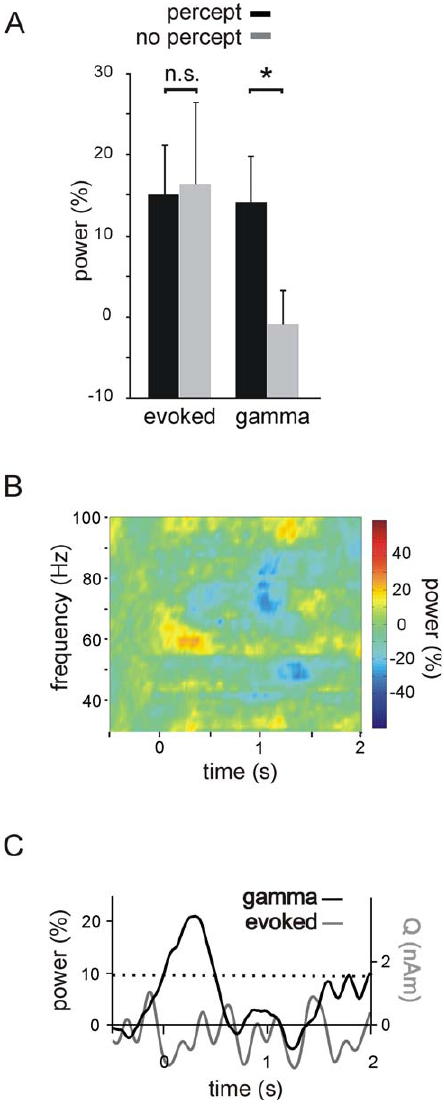
Figure 4. Amplitudes of Induced Gamma Oscillations and Evoked Responses to Differently Perceived Stimuli of Equal Stimulus Intensity (A) Trials rated with zero ( ‘‘ no percept, ’’ black bars) were compared to trials with higher ratings ( ‘‘ percept, ’’ gray bars) but the same stimulus intensity. Amplitudes of responses were calculated as relative power changes as compared to baseline. Mean rating of ‘‘ percept ’’ trials was seven, the mean number of trials per subject was 16. ‘‘ Percept ’’ and ‘‘ no percept ’’ trials were equally distributed across the recording session (ratio of the number of ‘‘ percept ’’ and ‘‘ no percept ’’ trials compared across quarters of the recording session; p ¼ 0.14; Friedman’s analysis of variance). Mean amplitudes of gamma oscillations in S1 at 100–300 ms were significantly stronger for ‘‘ percept ’’ trials as compared to ‘‘ no percept ’’ trials. Amplitudes of evoked responses from S1 did not differ between conditions. The asterisk (*) indicates p , 0.05. (B) TFR of the difference between ‘‘ percept ’’ and ‘‘ no percept ’’ trials. Power is coded as relative power change as compared to baseline. The figure represents a subtraction of the ‘‘ percept ’’ and ‘‘ no-percept ’’ TFRs, and demonstrates ‘‘ percept ’’ -specific enhanced gamma oscillations at a maximum latency of about 200 ms. (C) Group-mean amplitude differences between ‘‘ percept ’’ and ‘‘ no percept ’’ trials. The black line shows amplitudes of induced gamma oscillations as relative power changes as compared to baseline, and the gray line shows amplitudes of evoked responses calculated as source strengths from S1. The dotted line represents the 95% confidence interval calculated from baseline. Gamma amplitudes are significantly different between ‘‘ percept ’’ and ‘‘ no percept ’’ trials, whereas ampli- tudes of evoked responses did not differ between trial sets. doi:10.1371/journal.pbio.0050133.g004 PLoS Biology |